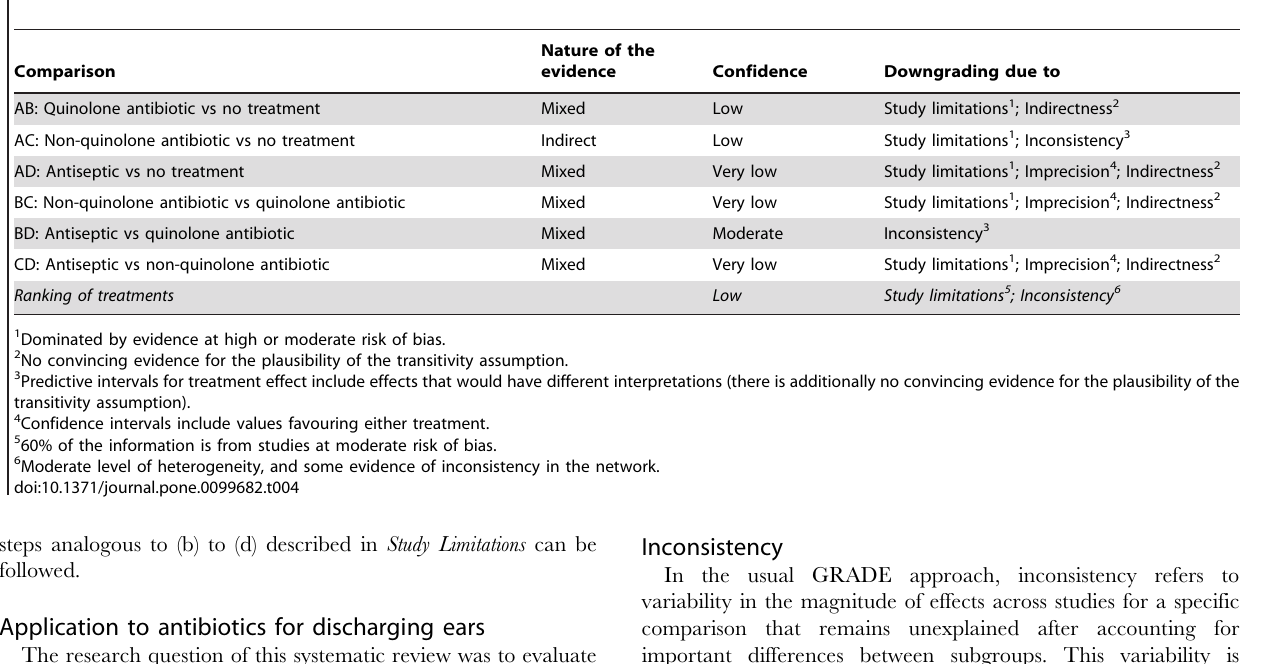
Table 4. Summary of our confidence in effect estimates and ranking of treatments.